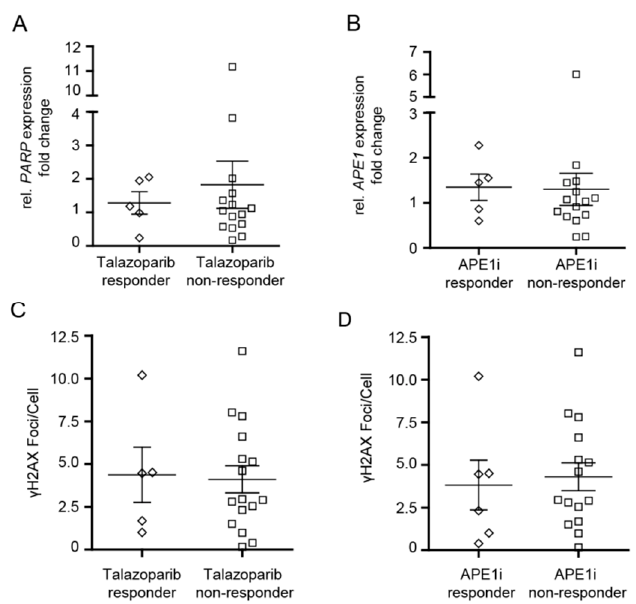
Figure 3. Cytotoxic efficacy of talazoparib and APE1 inhibitor III in CD34+ myelodysplastic syndrome (MDS)/chronic myelomonocytic leukemia (CMML) cells and in CD34+ or CD34 − acute myeloid leukemia (AML) cells in relation to PARP1 / APE1 mRNA expression and γ H2AX foci levels. ( A , B ) PARP1 and APE1 mRNA expression levels in ‘responders’ and ‘non-responders’. ( C , D ) Levels of γ H2AX foci in ‘responders’ and ‘non-responders’. Error bars represent mean ± standard error of mean.